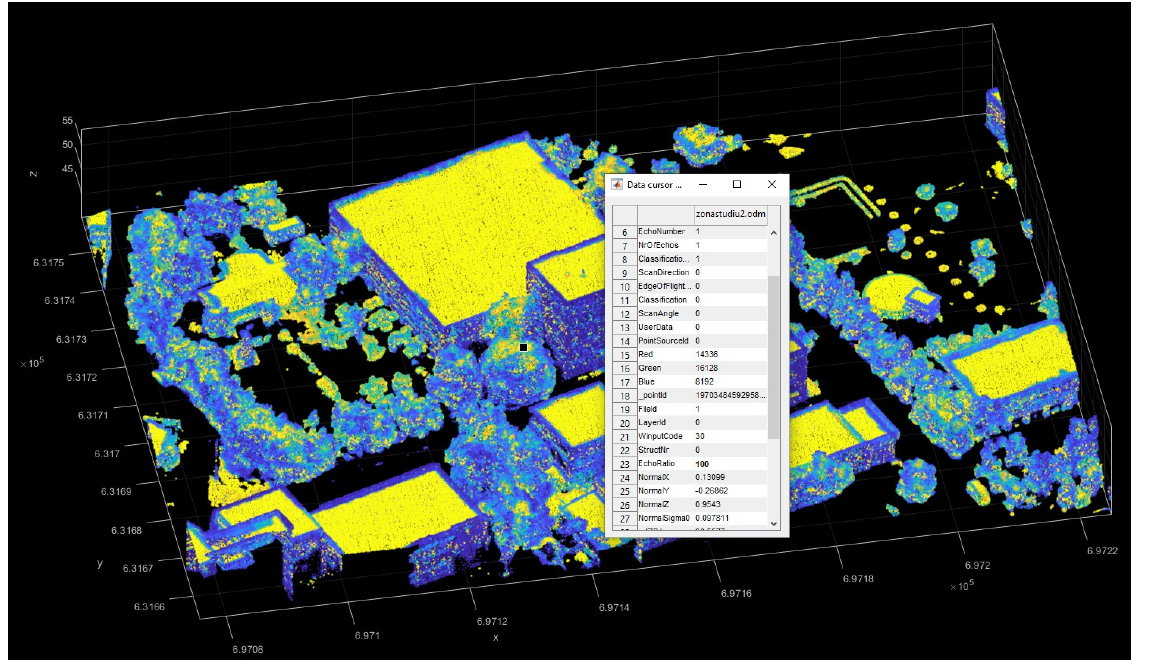
Figure 12. UAV point cloud colored based on EchoRatio attribute, yellow color indicates values of 100% for the ER attribute.